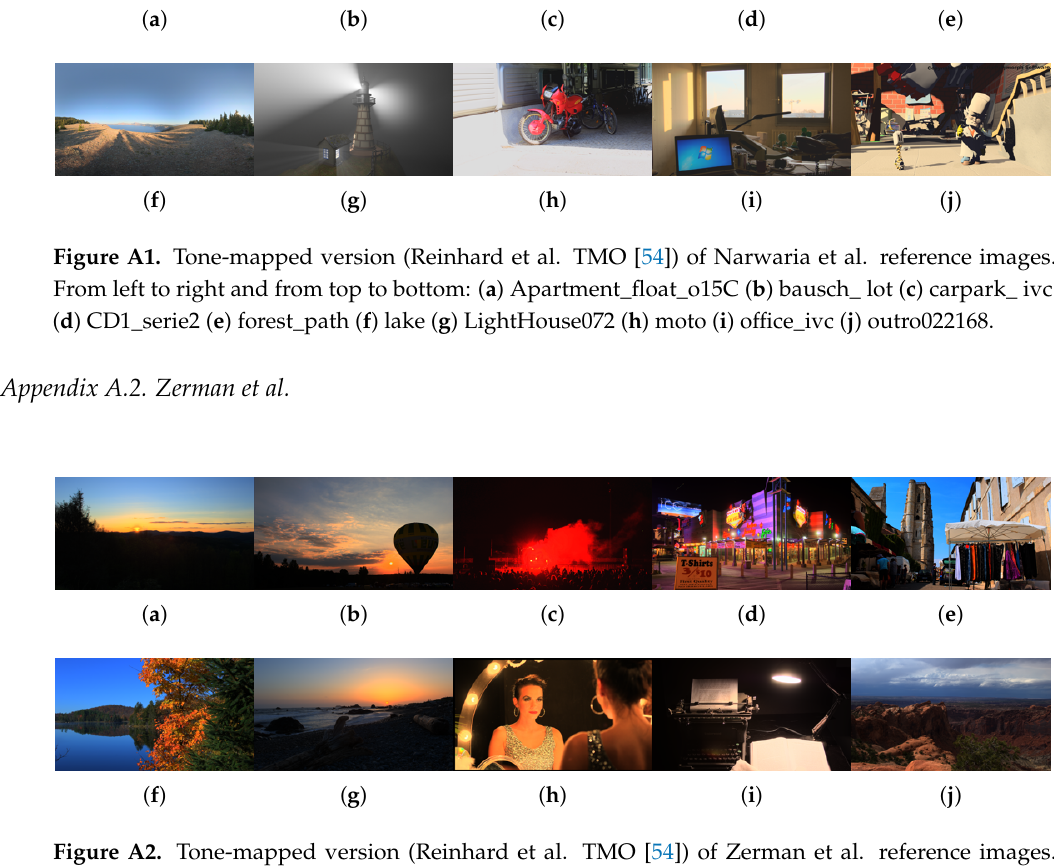
Figure A2. Tone-mapped version (Reinhard et al. TMO [54]) of Zerman et al. reference images. From left to right and from top to bottom: ( a ) AirBellowsGap ( b ) Balloon ( c ) FireEater ( d ) LasVegasStore ( e ) Market3 ( f ) MasonLake(1) ( g ) RedwoodSunset ( h ) Showgirl ( i ) Typewriter ( j )